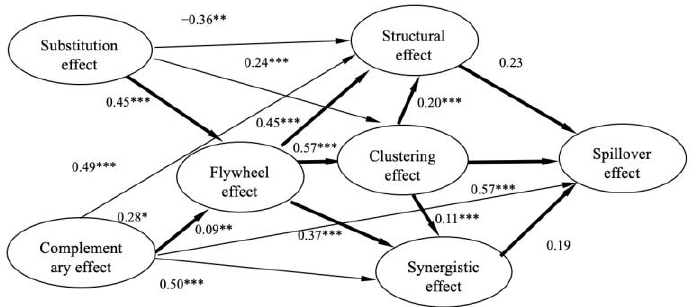
Figure 3. Structural equation modeling results for the effects of the digital economy on agricultural labor employment. (*, 𝑝 < 0.05; **, 𝑝 < 0.01; ***, 𝑝 < 0.001) Table 3. Fitting index results for the structural equation model.